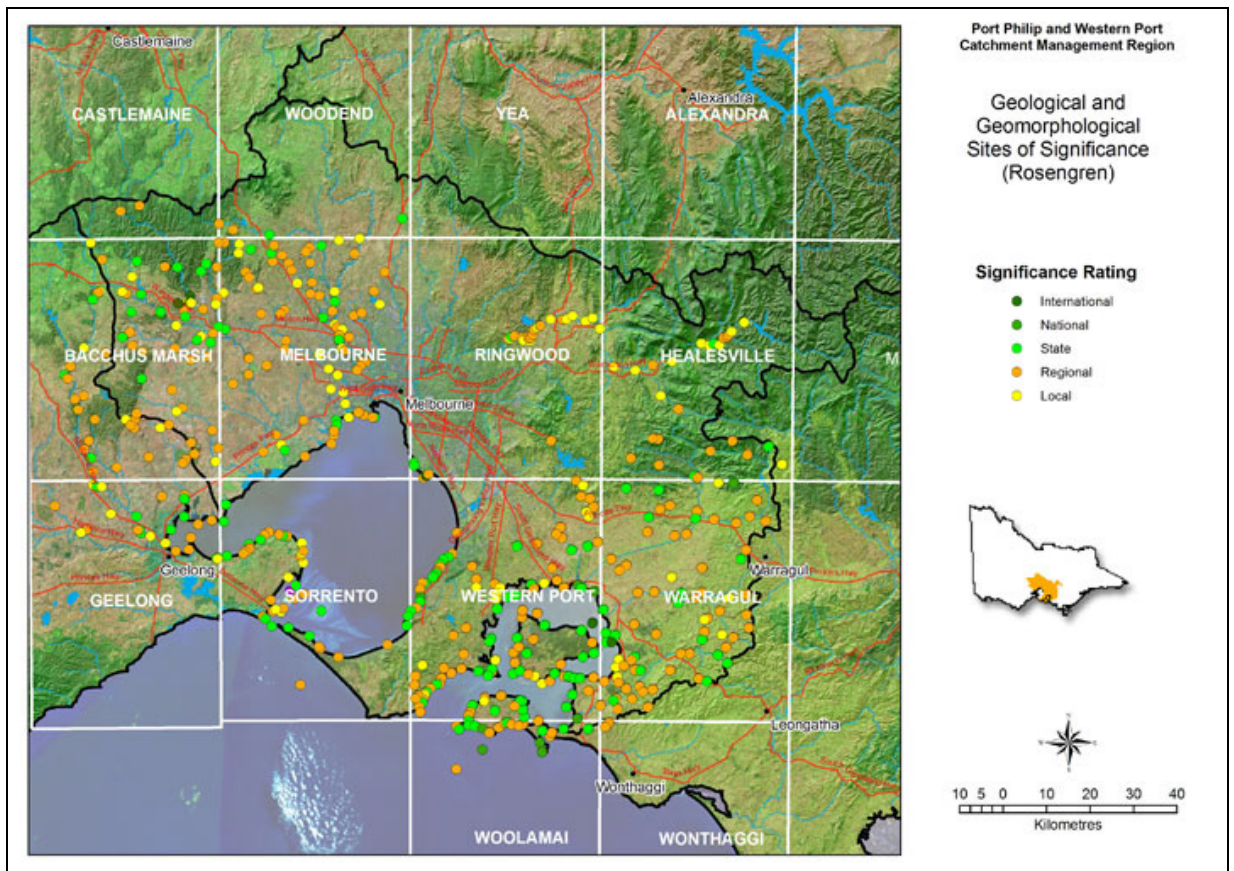
Figure 7. Overview map for a catchment management region showing location of Sites of Geological and Geomorphological Significance.  State of Victoria, Department of Primary Industries 1997 Reproduced with permission. From: